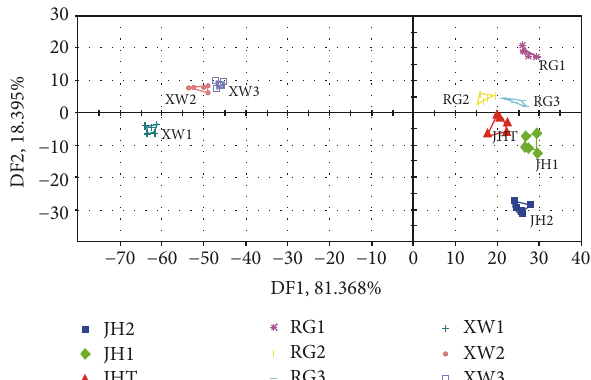
Figure 2: Discriminant function analysis (DFA) chart of different grades of three kinds of dry-cured hams by electronic nose. The abbreviations in the figure are referred to in Grades of Ham Samples and Their